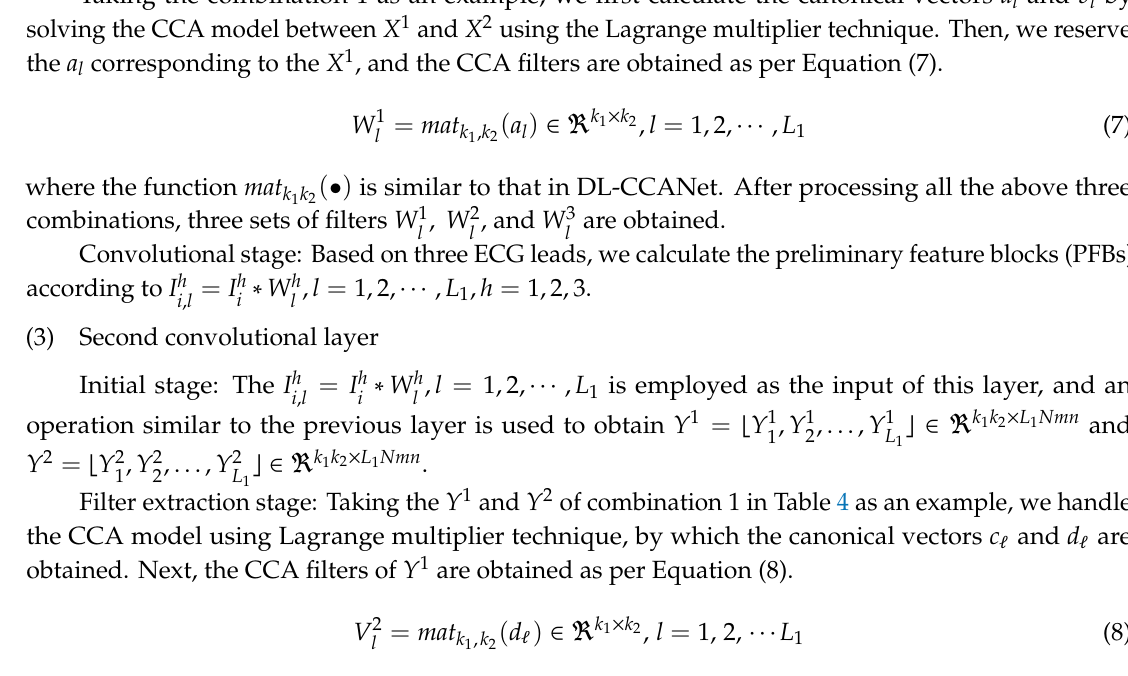
Table 4. The specific allocation